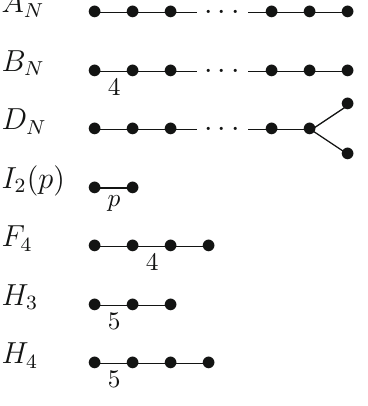
Fig. 1 Classification of irreducible finite Coxeter groups through Cox- eter diagrams. More Coxeter groups can be obtained by taking products of the groups given here. We have not included the diagrams of E 6 , E 7 and E 8 , all of which have more than four generators and are therefore irrelevant for us. Our nomenclature of the groups follows Ref. [40]. In each case, the subscript denotes the number of generators in the pre- sentation of the group. Products of the groups shown here qualify as Coxeter groups as